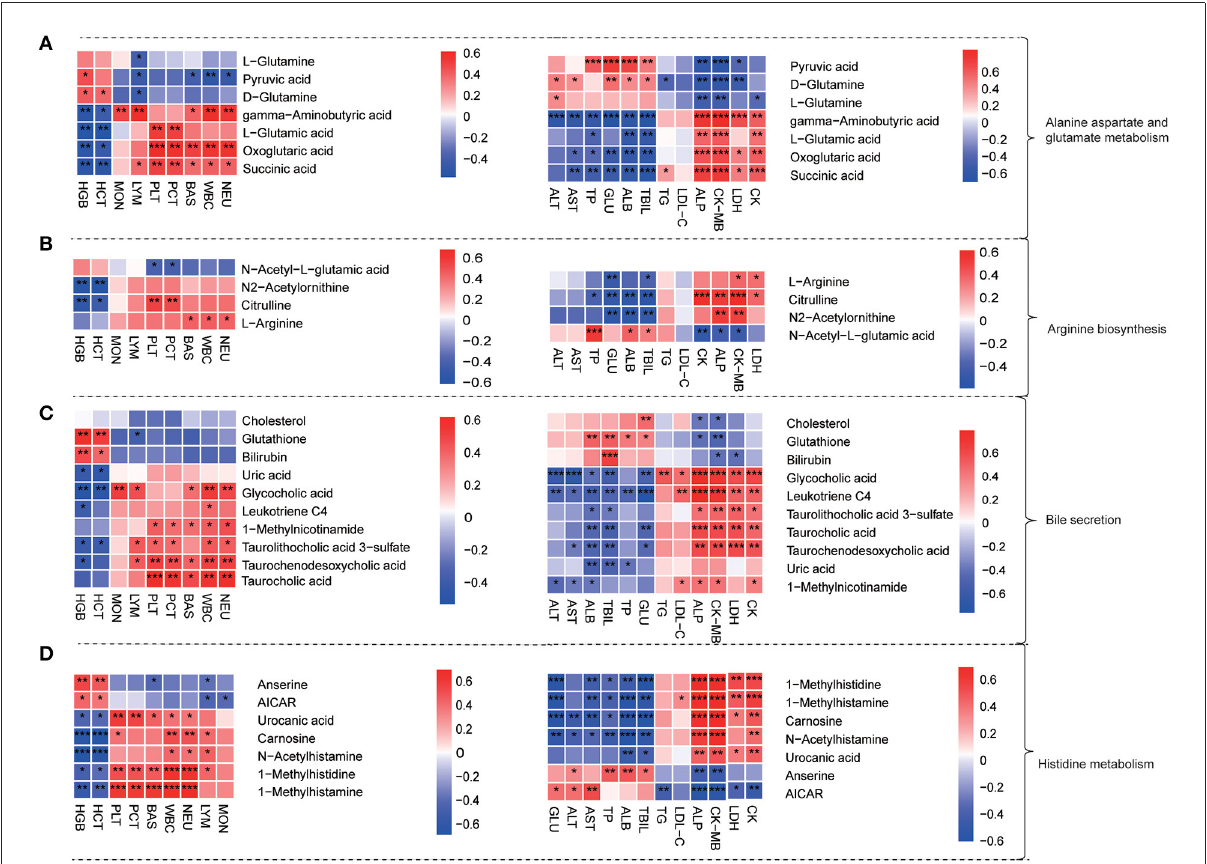
FIGURE5 Plasma metabolite profiles were correlated with age-related physiological index. (A–D) Heat map of the correlation between physiological indexes (significantly changed blood routine indicators and serum biochemical indicators) with differential plasma metabolites from alanine aspartate and glutamate metabolism pathway (A) , arginine biosynthesis pathway (B) , bile secretion pathway (C) , and histidine metabolism pathway (D) ; Heat map: red represented positive correlation and blue represented negative correlation. Significance levels * P < 0.05, ** P < 0.01, *** P <